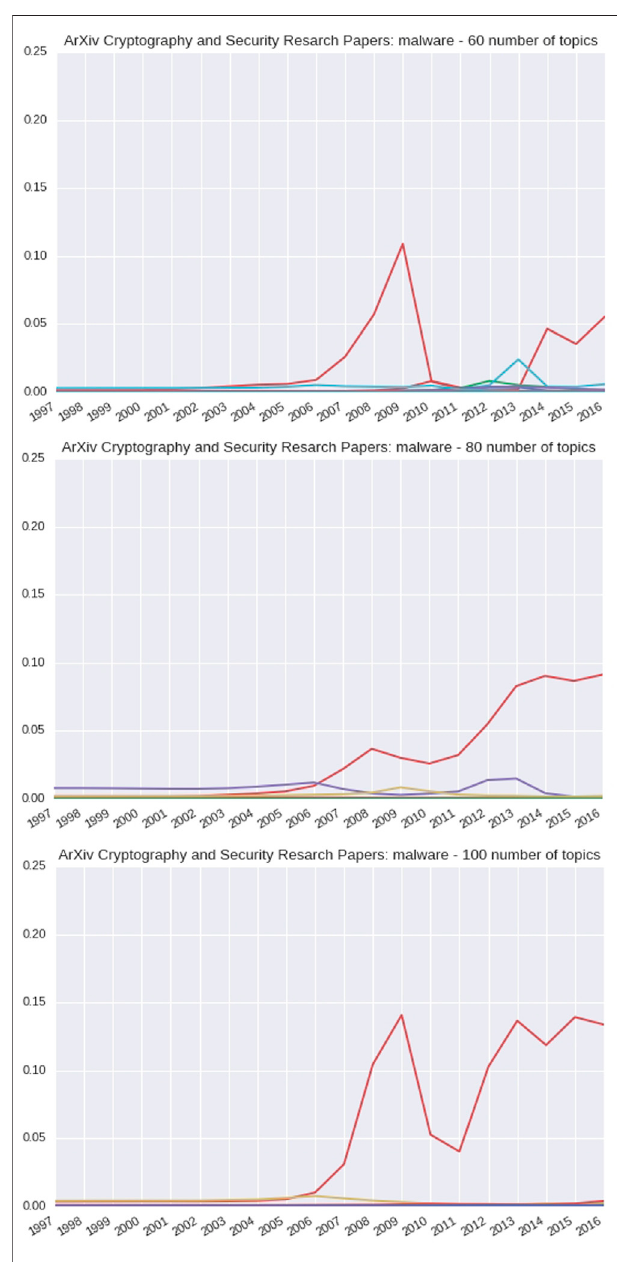
FIGURE 8 | 60-, 80-, and 100-topic arXiv Cryptography and Security research articles of the DTM concept: Malware.